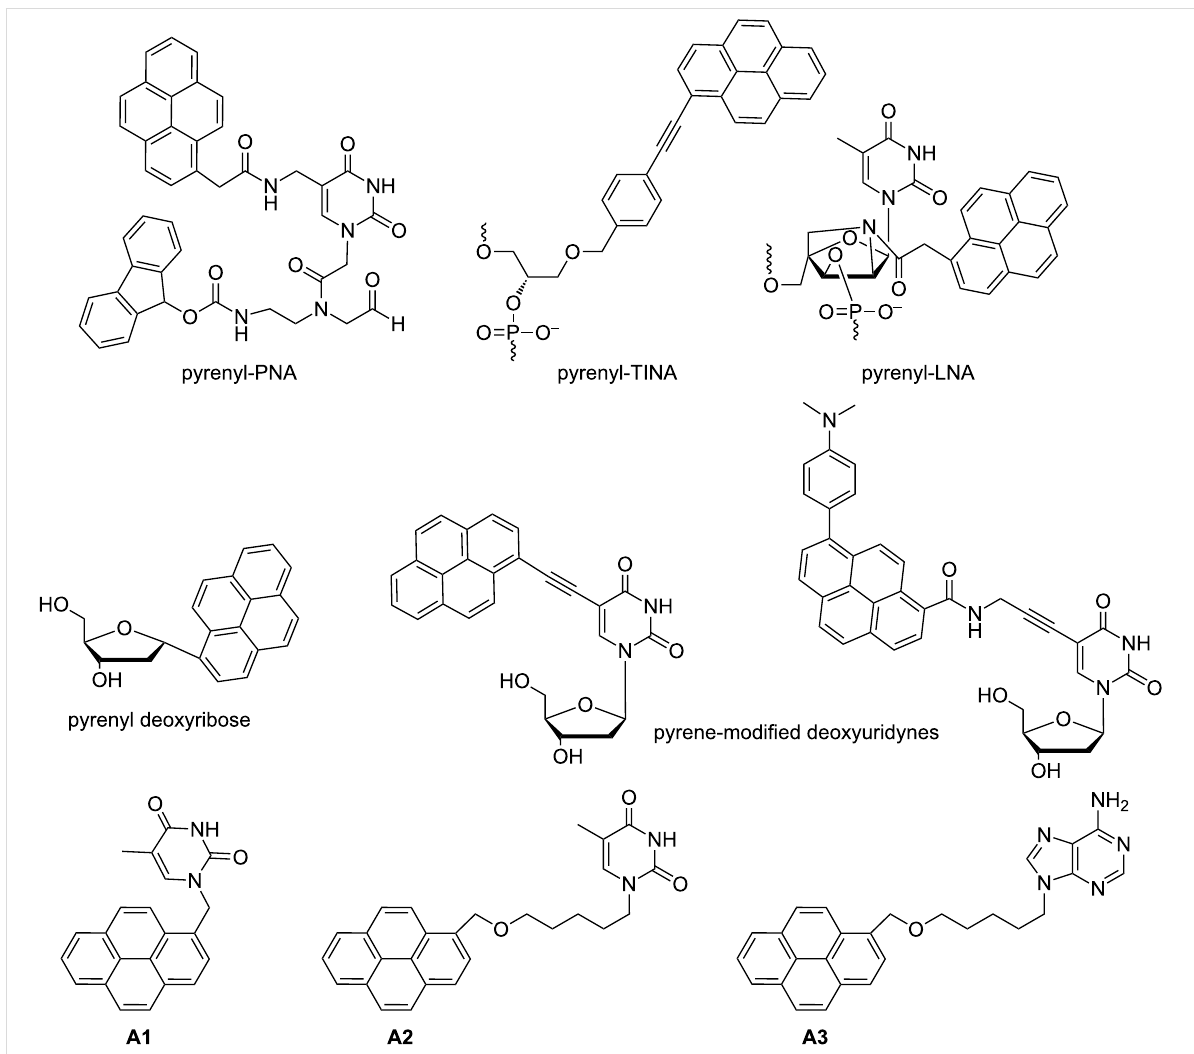
Figure 1: Examples of pyrene derivatives with relevance to nucleic acid chemistry and structures of pyrenyl–nucleobase conjugates A1 – A3